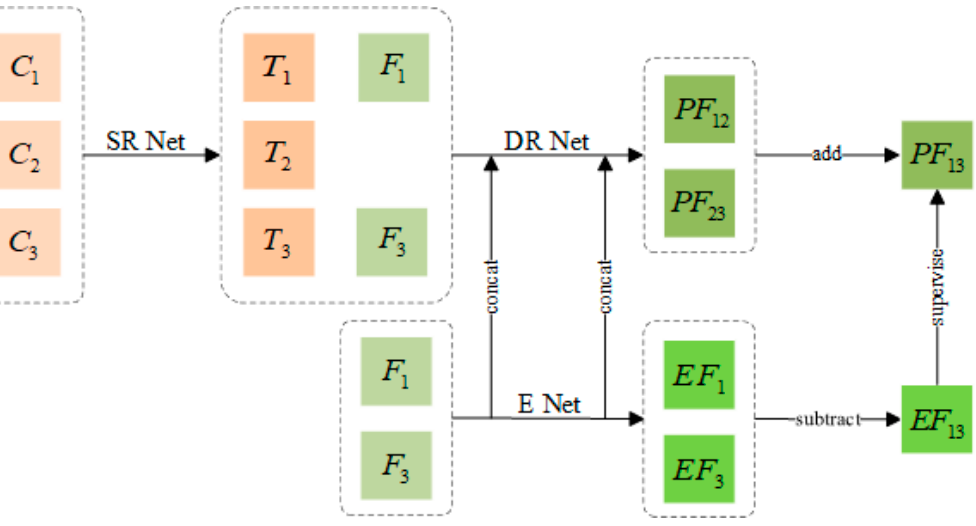
Figure 1. Model training flowchart. Here, the SR Net, the DR Net, and the E Net, (cid:1829) (cid:3036) , (cid:1832) (cid:2869) , and (cid:1846) (cid:3036) represent coarse, fine, and transitional images acquired at time (cid:1872) (cid:3036) and (cid:1842)(cid:1832) (cid:3036)(cid:3037) represents fine differ- represent coarse, fine, and transitional images acquired at time t i and PF ij represents fine difference ence images between (cid:1872) (cid:3036) and (cid:1872) (cid:3037) . images between t i and t j